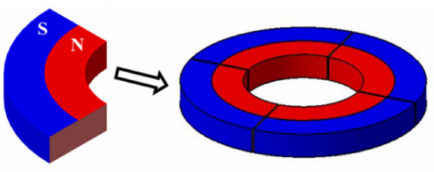
Figure 10. Design of the permanent